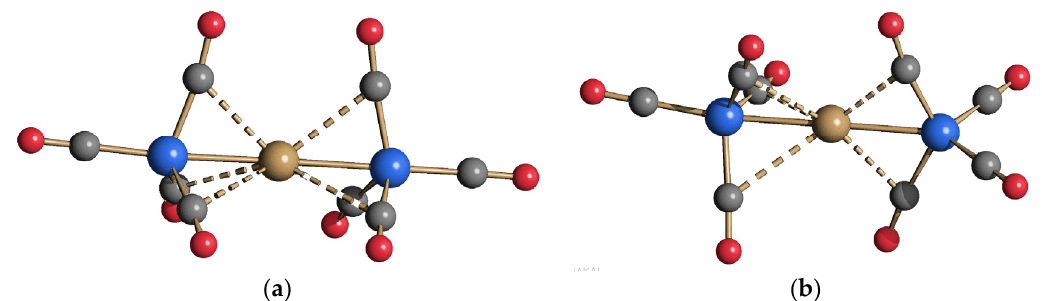
Figure 4. Molecular structures of 2 as found in ( a ) [Cu(dmpe) 2 ]( 2 ) (eclipsed conformation; TBP-TBP eclipsed isomer) and ( b ) [PPN]( 2 ) (TBP-Td isomer). Sub Van der Waals M ··· C(O) contacts are represented as fragmented lines (brown, Cu; blue, Co; red, O; grey, C) [40].